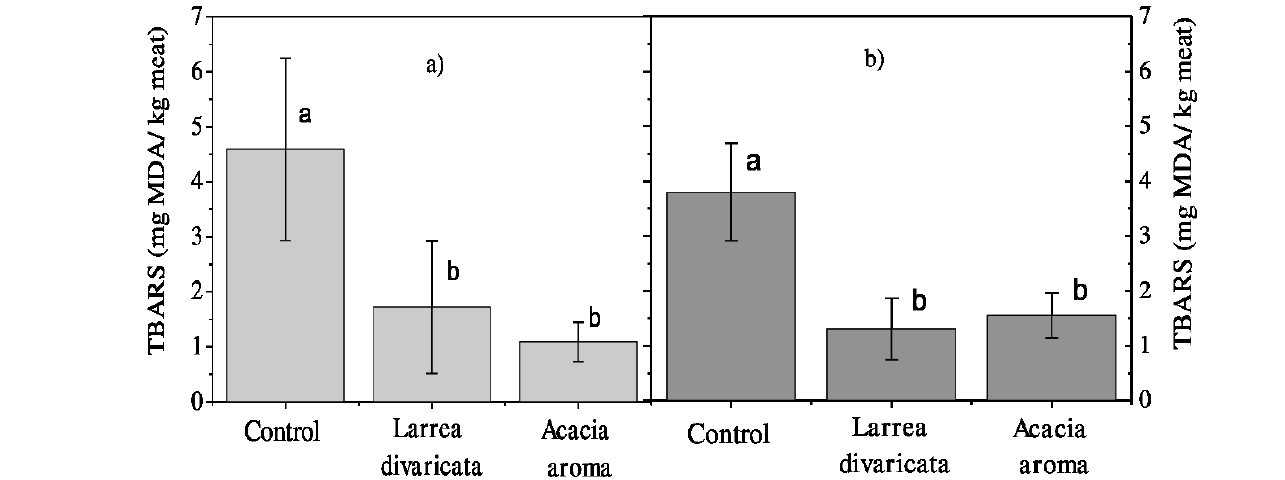
Figure 2. Main effects of dietary treatment on oxidation marker levels of goat meat stored (a) at 26°C for 6 h and (b) at –18°C for 30 days. Values presented are the mean 2-thiobarbituric acid reactive substances values and standard error bars. a,b Within each storage temperature, different superscripts indicate differences between dietary treatments (p≤0.05) tested using LSD Fisher test (p<0.05).